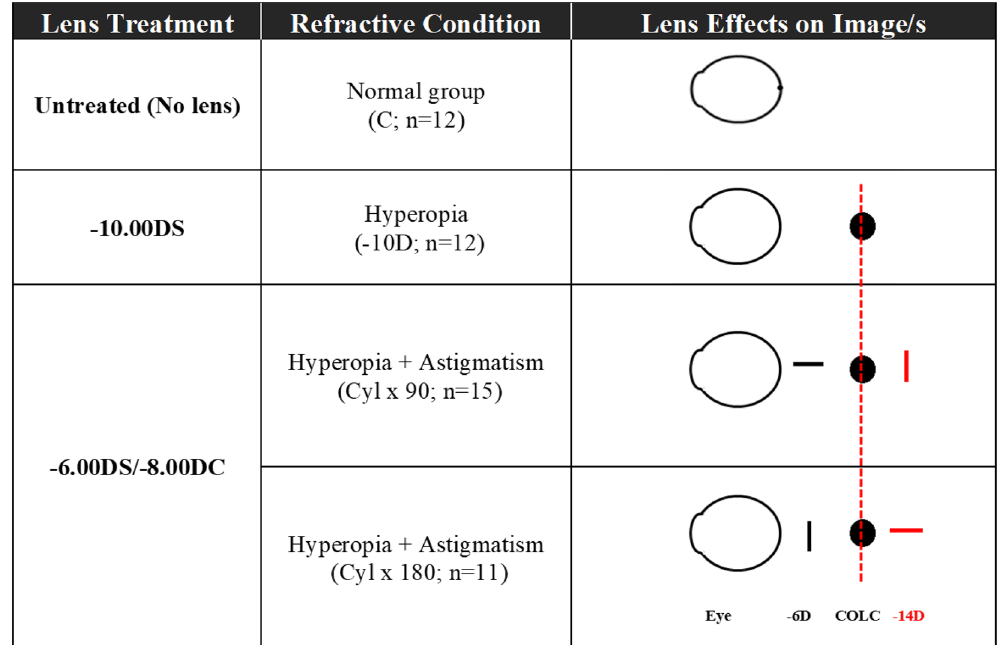
Table 4. Experimental groups and their treatment conditions. Fifty chicks were randomly assigned to four groups as follows: no treatment (Normal; n = 12), negative spherical lenses (− 10 D, n = 12), sphero-cylindrical lenses oriented vertically (H-WTR; n = 15), sphero-cylindrical lenses oriented horizontally (H-ATR; n = 11). Sphero-cylindrical lenses (− 6.00 DS/− 8.00 DC), imposing the same magnitude of spherical equivalent (hyperopic) defocus as the – 10 D group, were used to induce myopic-astigmatic eye growth. The lenses were chosen such that they impose – 8 D of astigmatism and the orientation of the sphero-cylindrical lenses was altered to simulate two common clinical forms of astigmatism: “With the rule”, WTR and “Against the rule”,